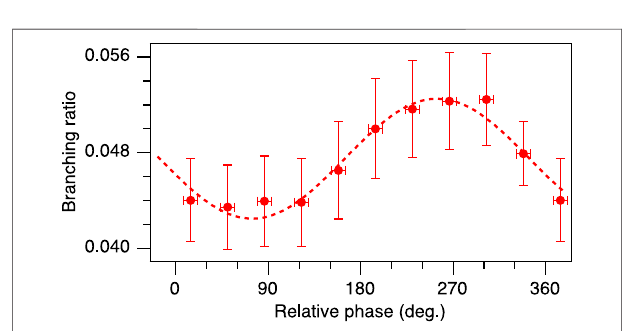
FIGURE 8 | Inter-channel branching ratio between the OC + and the O + fragments ejected tothesamedirection asafunction ofthe relative phase at a total peak intensity of 2×10 14 W/cm 2 and a ratio α = 0.14. Red circles correspond to experimental data points, the dotted line is a sine fi t.